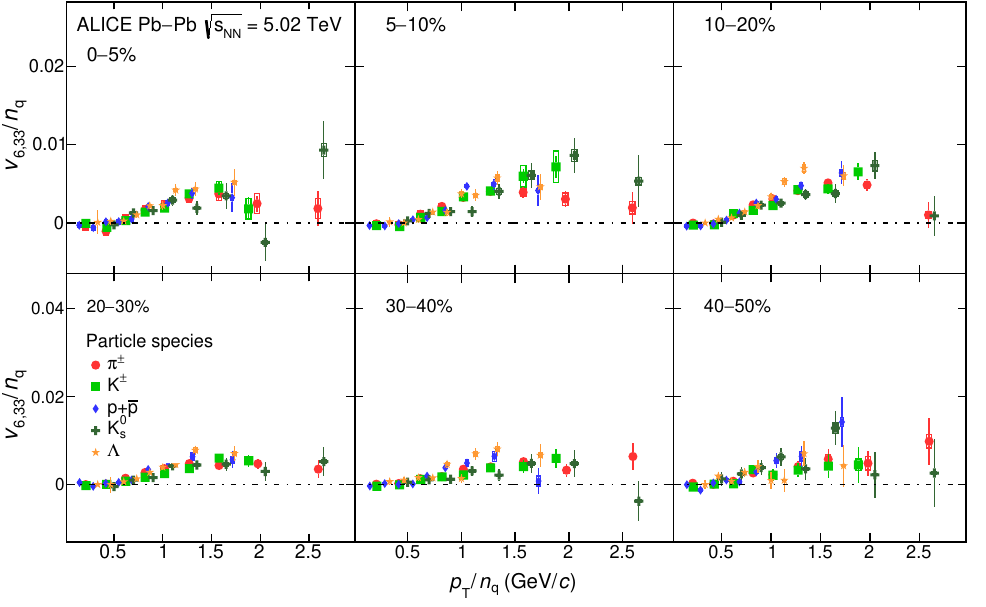
Figure 12 . The p T =n q -dependence of v 6 ; 33 =n q for di(cid:11)erent particle species grouped into di(cid:11)erent p centrality intervals of Pb-Pb collisions at s NN = 5 : 02 TeV. Statistical and systematic uncertainties are shown as bars and boxes, respectively.